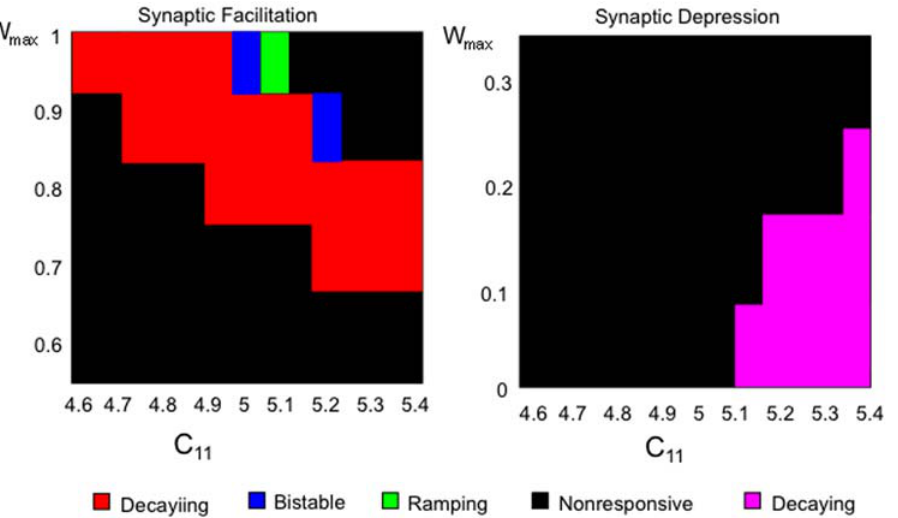
Figure 4. Phase Diagram of different patterns exhibited by the single population model as a function of the maximum facilitation parameter and self-connectivity. Left : Patterns exhibited with dynamic synaptic facilitation. Actual facilitation is less than the maximum facilitation parameter and falls within a physiological reasonable range (10–60%). Right : Patterns exhibited with dynamic synaptic depression which takes place when values of W max are less than the baseline level ( W min ). Pattern activity was determined by examining the firing rate activity during 3 periods of the working memory task: the first 5 seconds of the delay period (D1) immediately following the cue, the second 5 seconds of the delay period (D2), and the last 5 seconds of the baseline period (B) immediately preceding the cue period. Significant differences were taken to be present if the absolute difference between any two periods was greater or equal to 0.5 Hz, which is approximately the lower limit of significant differences observed in the real cortical parietal and prefrontal cells. Fixed rate memory cell behavior consisted of activity in which the absolute difference in average firing rate between D1 and D2 was less the 0.5 Hz, while both those periods exhibited an average firing rate greater or equal to 0.5 Hz above the baseline rate. Ramping cue-coupled cell behavior consisted of activity in which D2 exhibited an average firing rate greater or equal to 0.5 Hz above that of D1, and the firing rate of D1 was greater or equal to that of B. Decaying memory cell behavior consisted of activity in which D1 exhibited an average firing rate greater or equal to 0.5 Hz above both B and D1. Nonresponsive cell behavior consisted of activity in which the difference between any of the periods (B, D1, and D2) was less than 0.5 Hz. Decaying inhibition cell behavior consisted of activity in which the average firing rate during D1 was at least 0.5 Hz less than that exhibited during B and